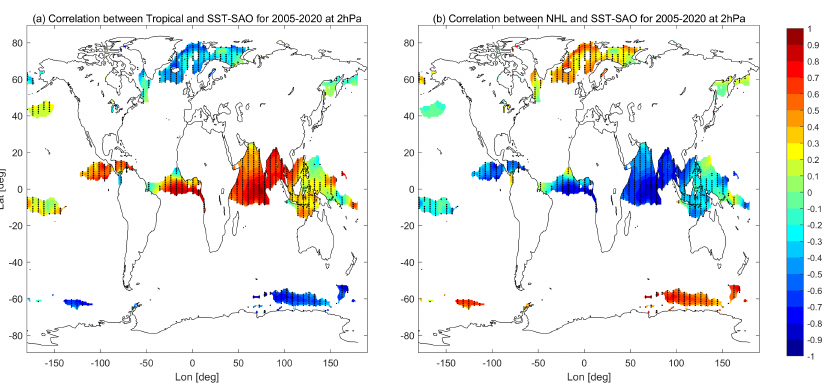
Figure 8. The correlation between MLS temperature SAO signal at 2 hPa averaged around the tropical region (10 ◦ S–10 ◦ N) ( a ), the NH high latitudes (70 ◦ S–82 ◦ S) ( b ) and SST-SAO. The dots mark the significant area at 95% level.